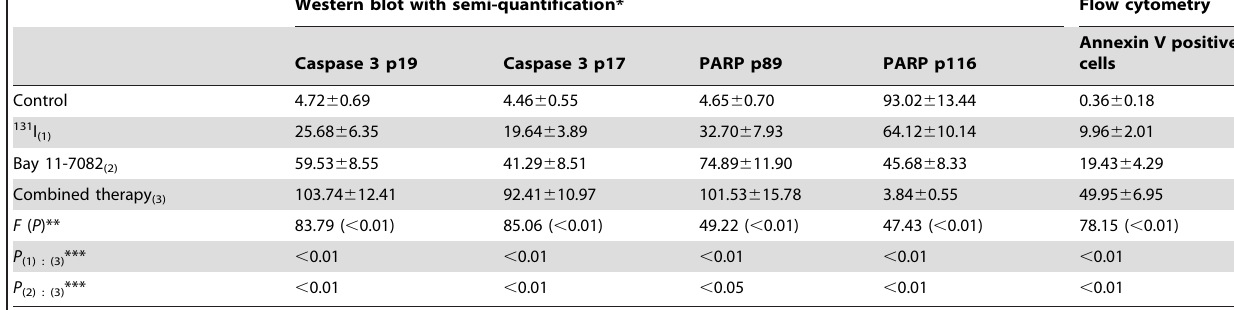
Western blot with semi-quantification*